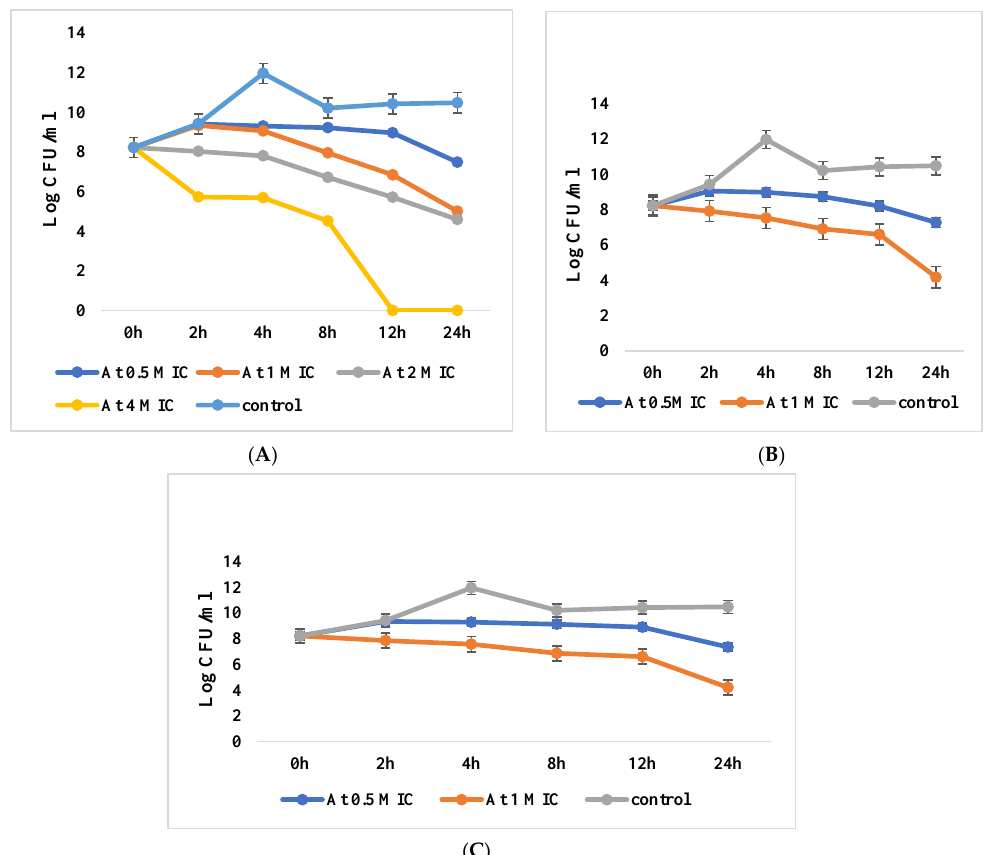
Figure 2. ( A ) Killing curves of imipenem and amikacin resistant P. aeruginosa incubated without antibiotic (control), with mikacin + imipenem at different concentrations (0.5 × MIC, 1 × MIC, 2 × MIC, 4 × MIC). ( B ) Killing curves of imipenem-resistant Pseudomonas aeruginosa incubated without antibiotic (control), with amikacin + imipenem at different concentrations (0.5 × MIC, 1 × MIC). ( C ) Killing curves of amikacin resistant P. aeruginosa incubated without antibiotic (control), with amikacin + imipenem at different concentrations (0.5 × MIC, 1 × MIC).